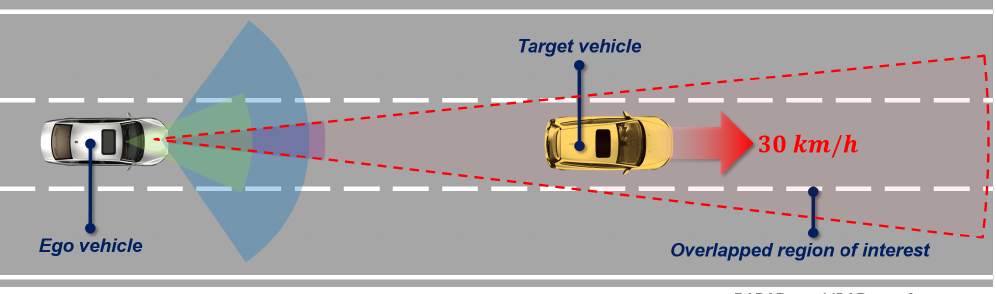
Figure 13. Scenario for evaluating the online multi-sensor coordinate correction.